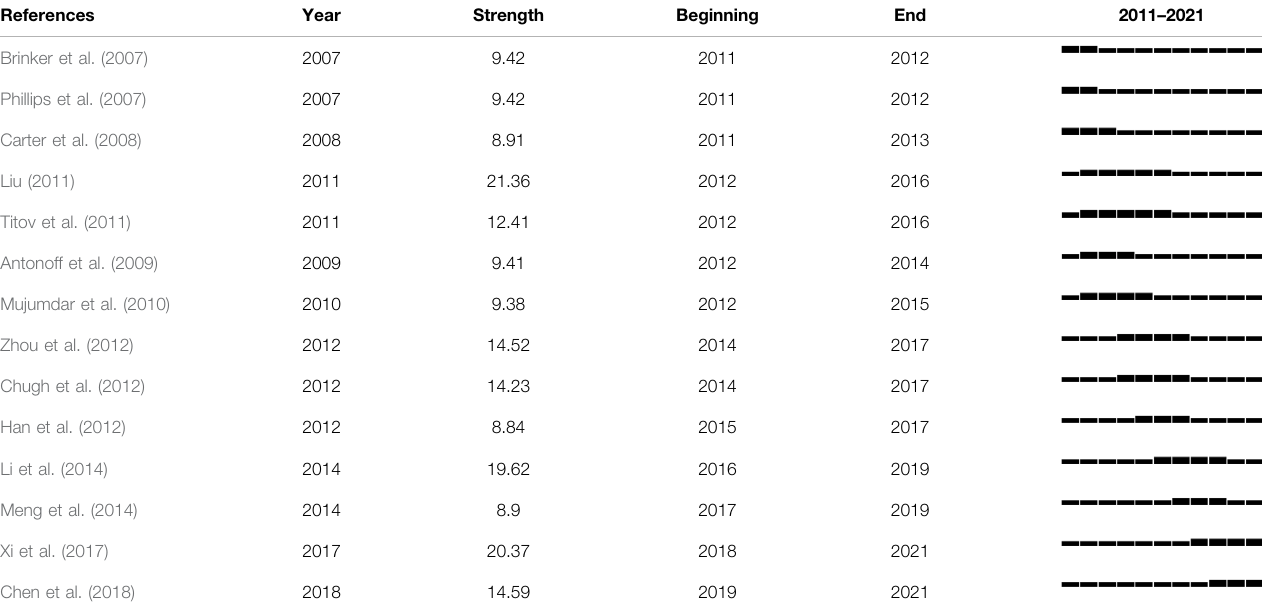
TABLE 2 | Top 14 references with the strongest citation